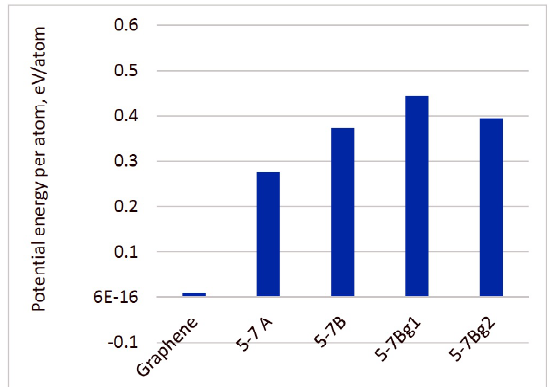
Fig. 5. Average specific potential energies (ener- gies per atom) of studied